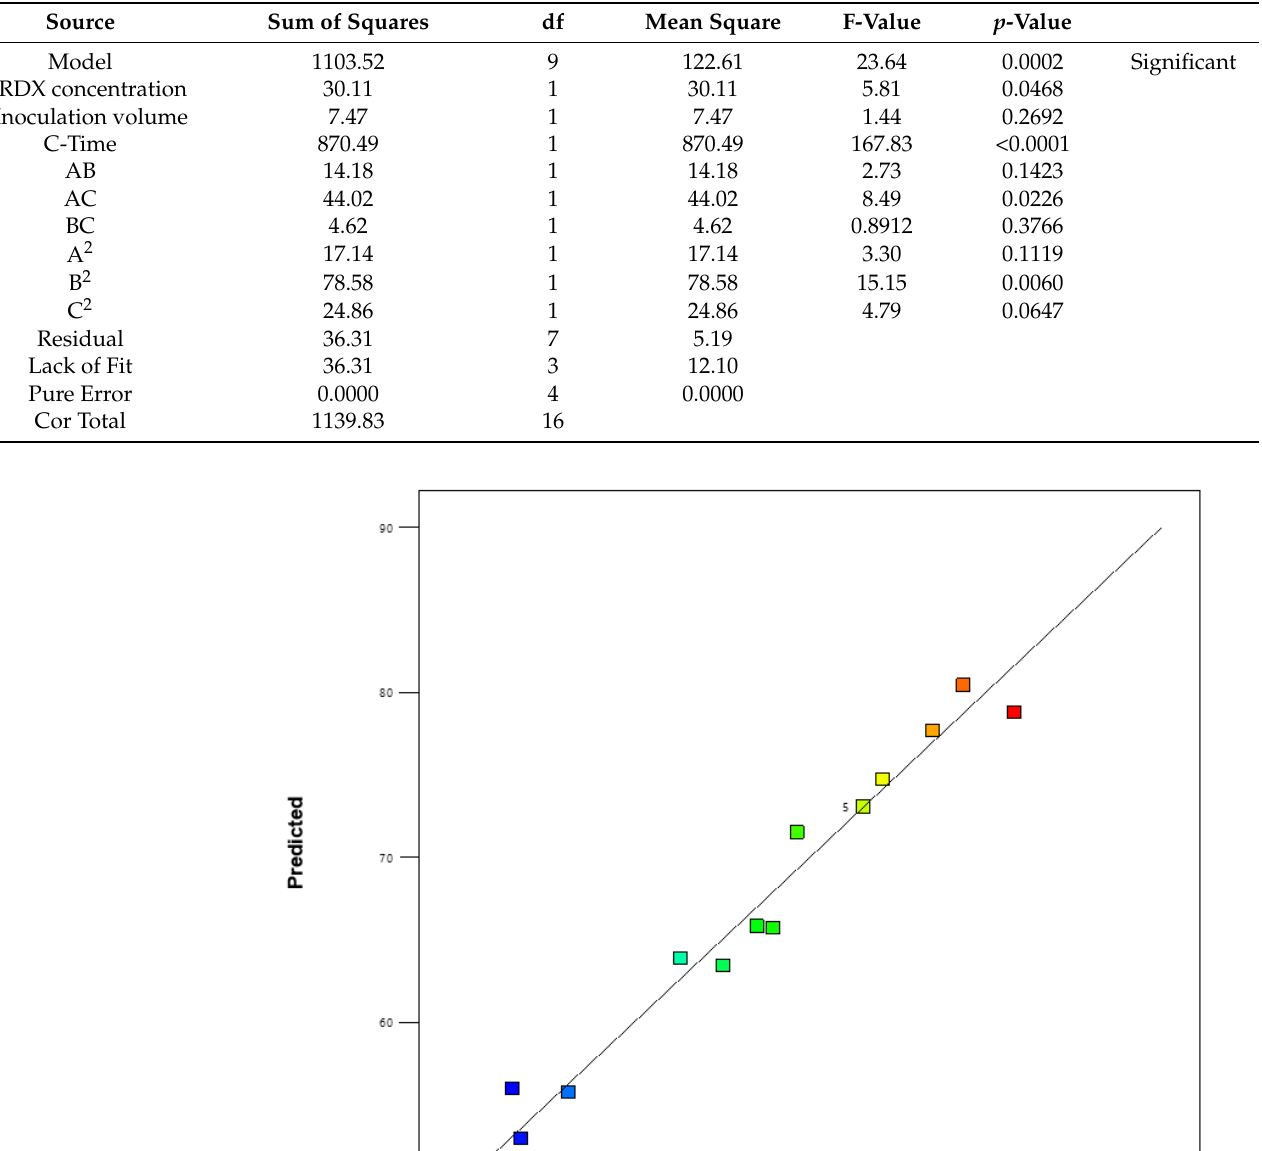
Figure 1. ( A ) 3-D model plot for the degradation of RDX under varying initial concentration (mg/L) and time (days) with Bacillus toyonensis. ( B ) 3-D model plot for the degradation of RDX under varying initial concentration (mg/L) and inoculum volume (%) with Bacillus toyonensis. Table 2. ANOVA of Quadratic model for percent degradation of RDX with Bacillus toyonensis.